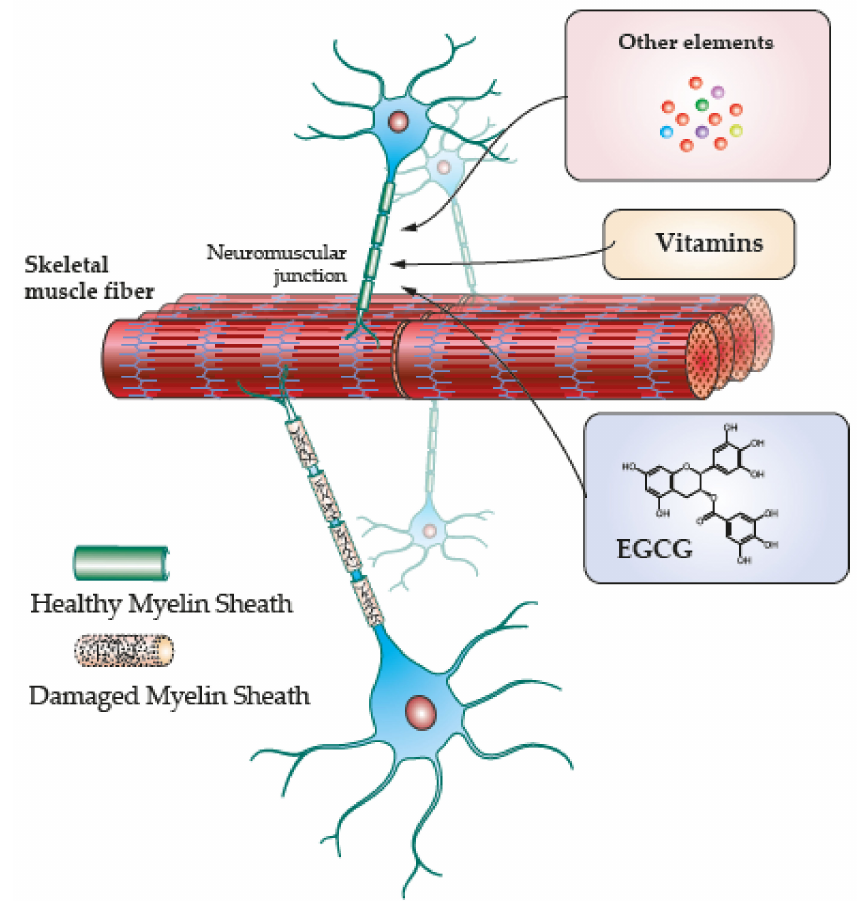
Figure 2. Exogenous antioxidants in regeneration. Damaged myelin impairs innervation and neu- romuscular junctions end in skeletal muscle fibers damage. Remyelination is one of the potential effects of exogenous antioxidants that activate mechanisms to induce regenerative effects in skeletal muscles including their functional